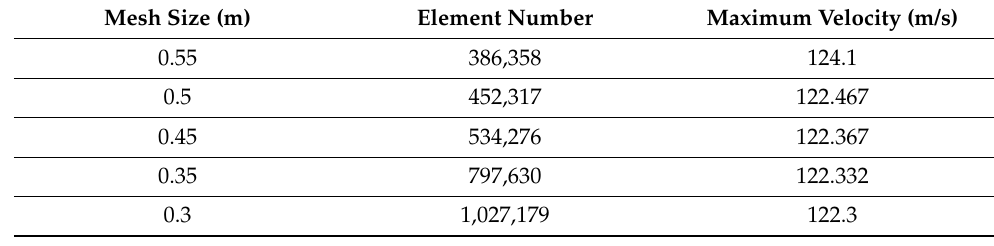
Table 1. Comparison between mesh size, number of elements, and maximum velocity for the fluid domain of the intake section.